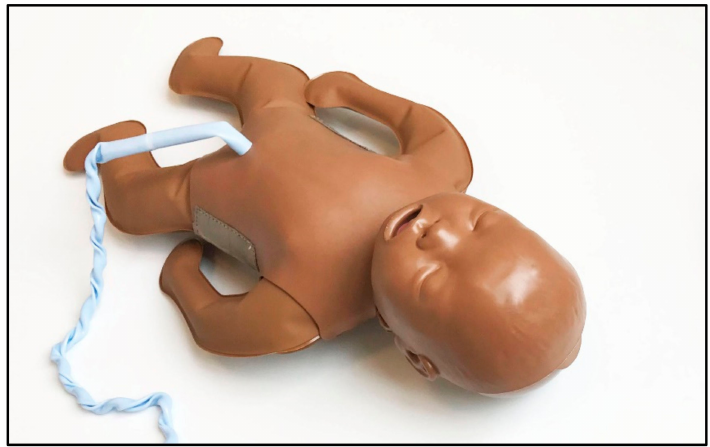
Figure 1. NeoNatalie Live